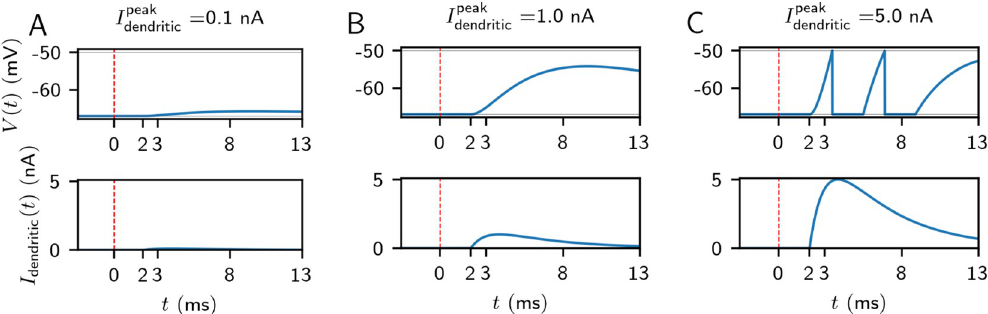
Fig 2. The impact of dendritic spikes on the soma. A dendritic spike is generated at t = 0 ms, marked by the red dashed vertical line. It is modeled by the dendritic current I dendritic (lower subpanels in A,B,C) arriving at the soma τ D = 2 ms later (here at 2 ms). For small peak dendritic currents ( I peak ¼ 0 : 1 nA , panel A), the somatic depolarization (upper subpanel) is dendritic small (here: 1.28 mV) when starting at rest. For larger peak dendritic currents, the somatic depolarization increases (12.78 mV for I peak ¼ 1 nA , panel B), but remains subthreshold. For I peak � 1 : 34 nA , at least one somatic spike is generated; dendritic dendritic for I peak ¼ 5 nA (panel C), two spikes are generated and there is significant depolarization visible in the membrane voltage dendritic even after the second spike. The scale for the bottom panels is fixed to facilitate comparison between the different values for the dendritic peak